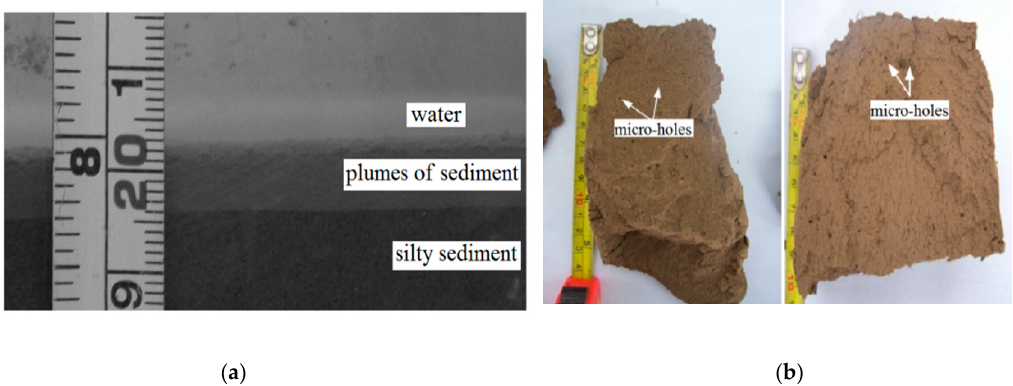
Figure 1. Plumes of sediment and micro-holes in silty sediment seabed: ( a ) The plumes of sediment on the silty sediment surface; ( b ) The micro-holes due to erosion. [4].